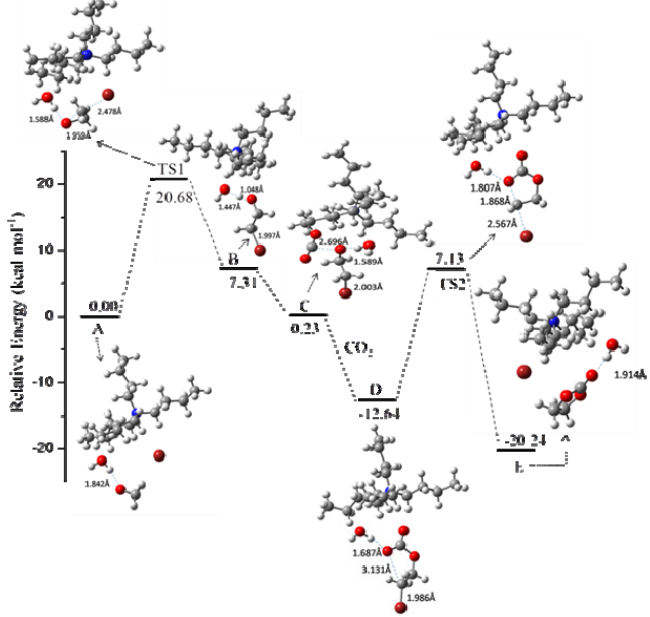
Figure 1. Potential energy surface profiles of [Bu Acknowledgements to be used by RSC authors.